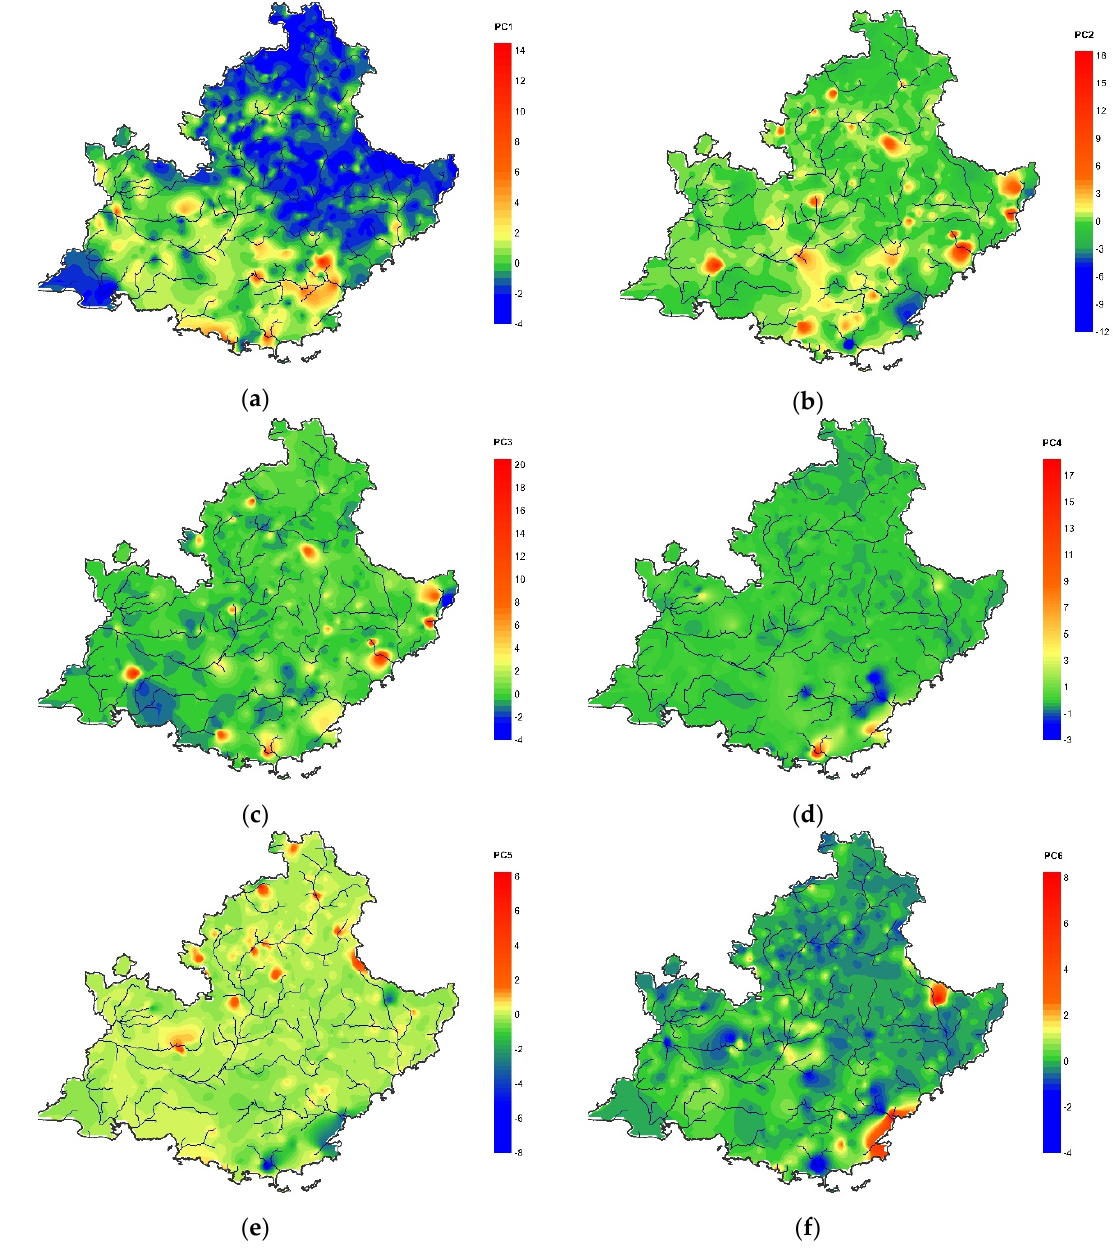
Figure 5. Distribution of the six first principal components ( a – f , respectively) in the PACA Region.